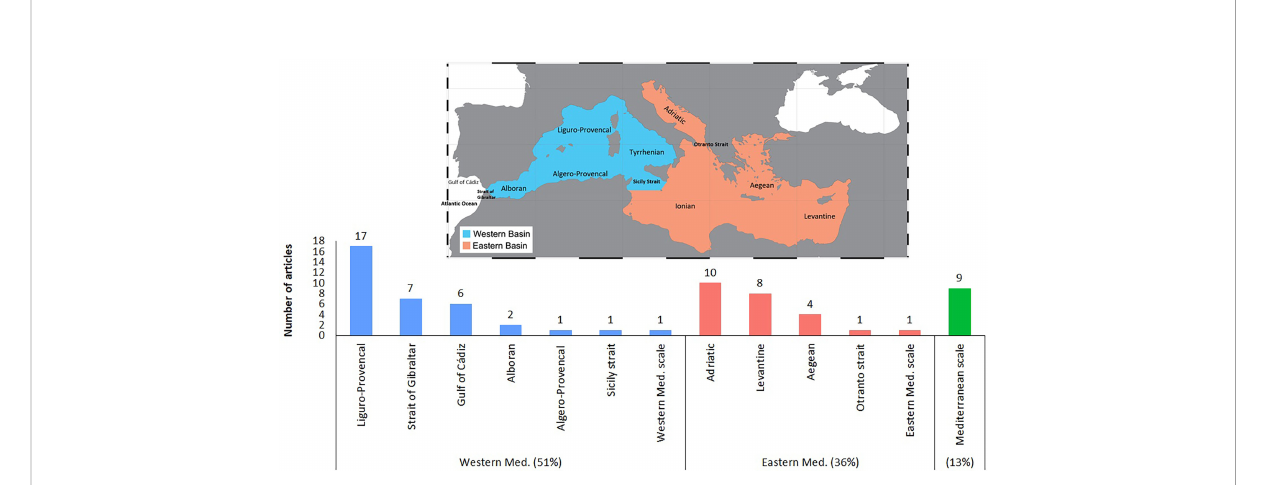
FIGURE 5 Number of OA biogeochemical articles in the various Mediterranean sub-basins and